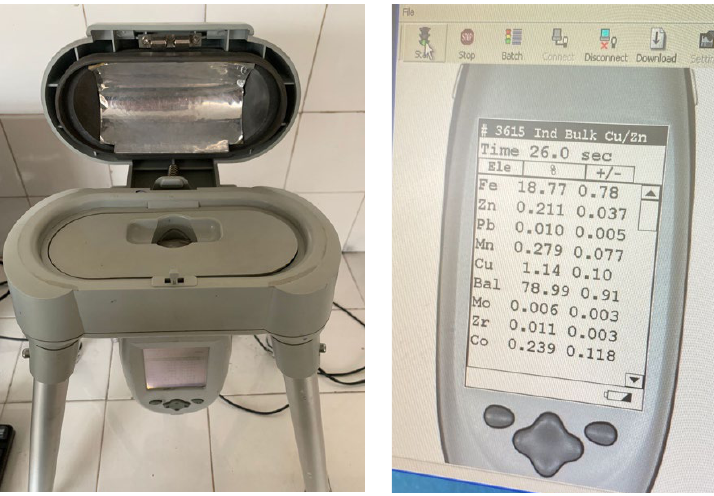
Figure 7. XRF test rig (Niton XLt) and its summary display (on the right).